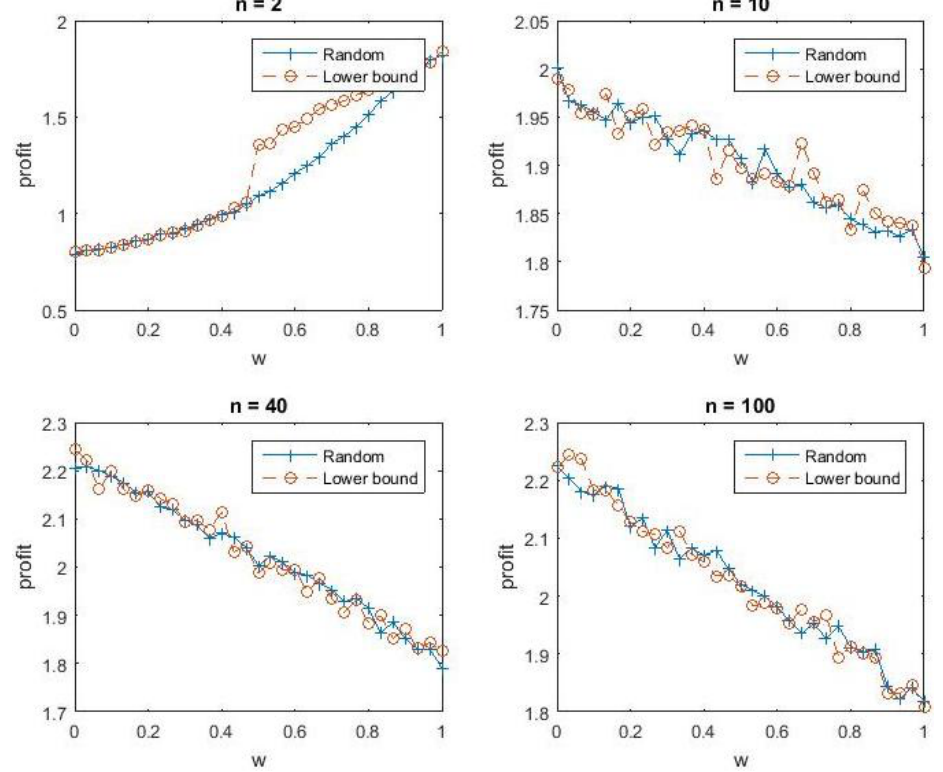
Figure 2. Criminal’s profit as a function of w for four different values of n when c = 0.1 and δ = 0.9.